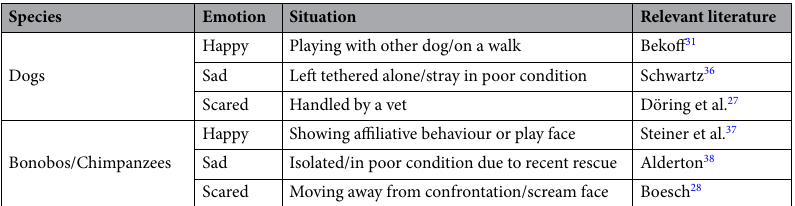
Table 3. Contextual instantiation of emotion in non-human facial